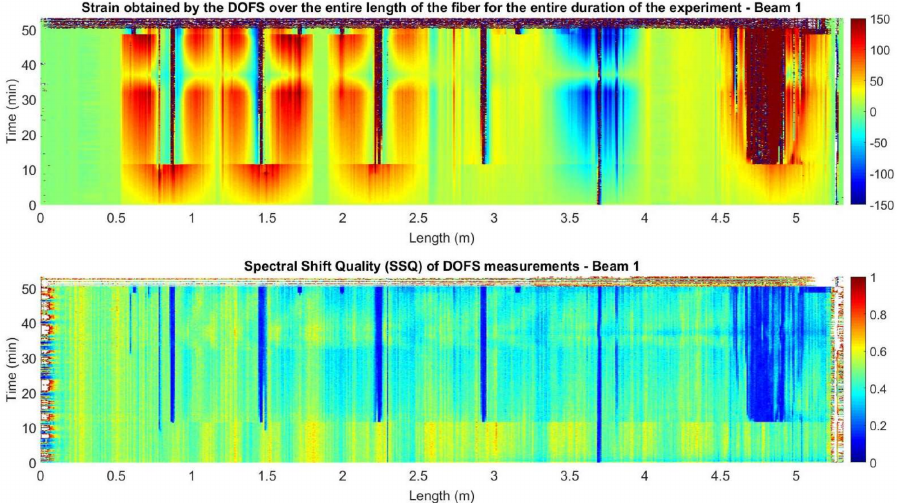
Figure 17. Strain and SSQ for beam 1.